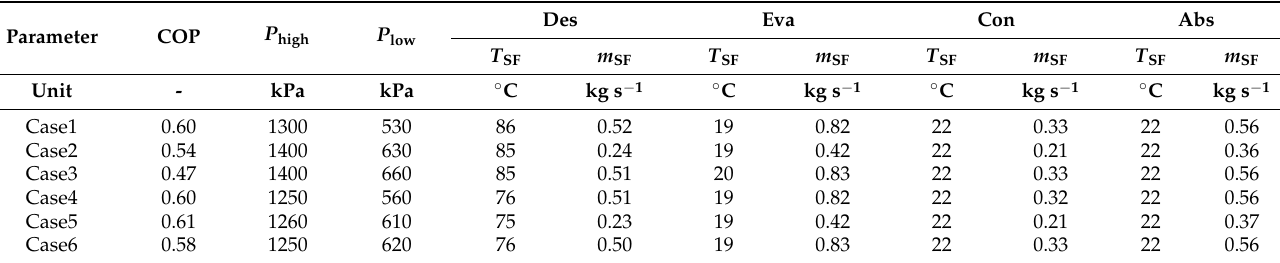
Table 1. Operating parameters of the experimental data